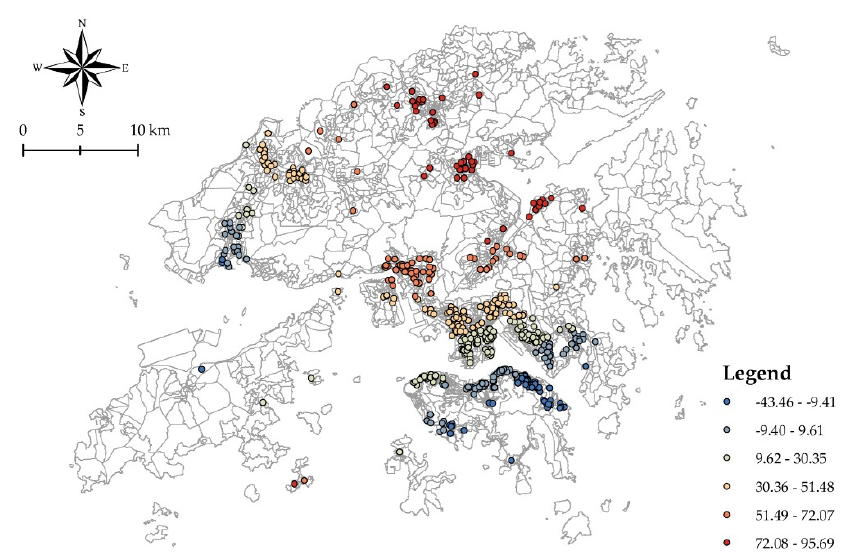
Figure 4. Geographical distribution of the coefficient of street greenery (800 m).